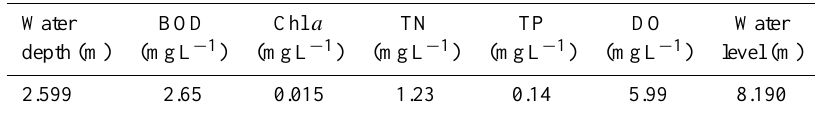
Table 6. Average water depth and water quality for Baiyangdian